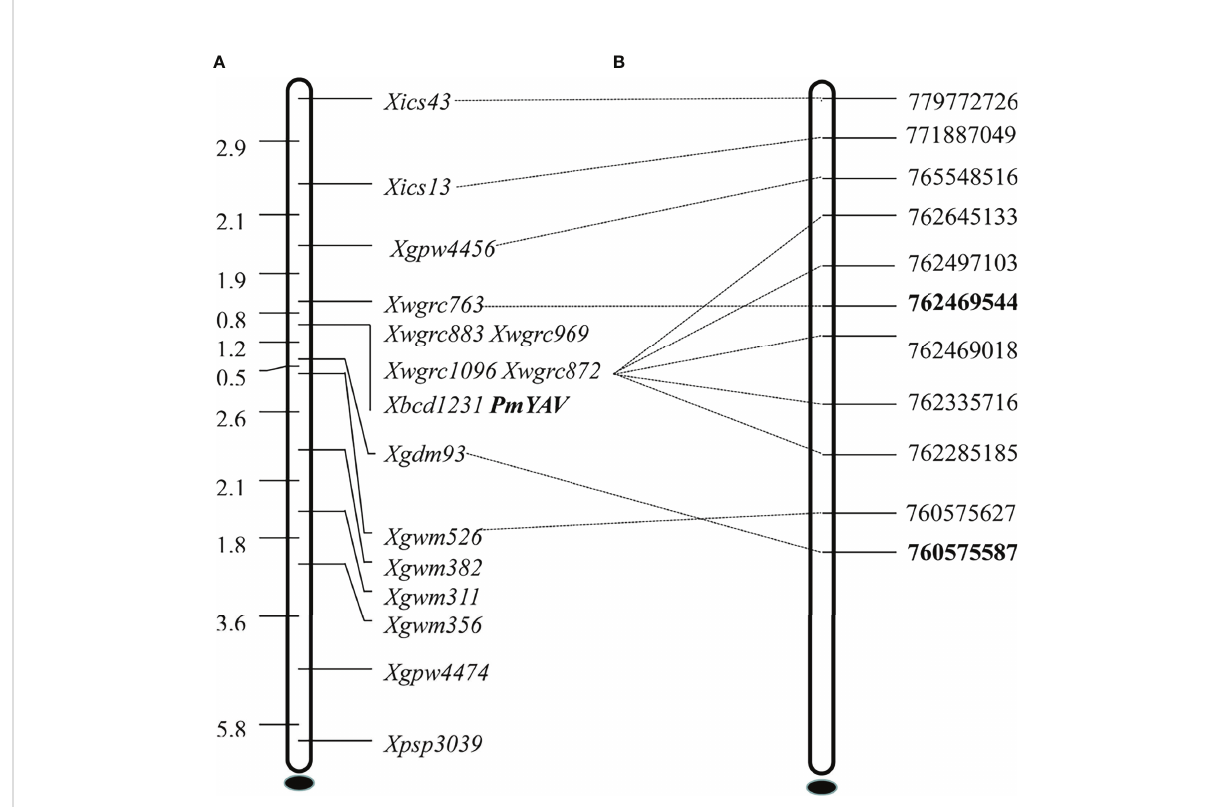
FIGURE 3 Genetic linkage map (A) and physical map (B) of powdery mildew resistance gene PmYAV using the F 2:3 families of YAV249/Shixin 828.